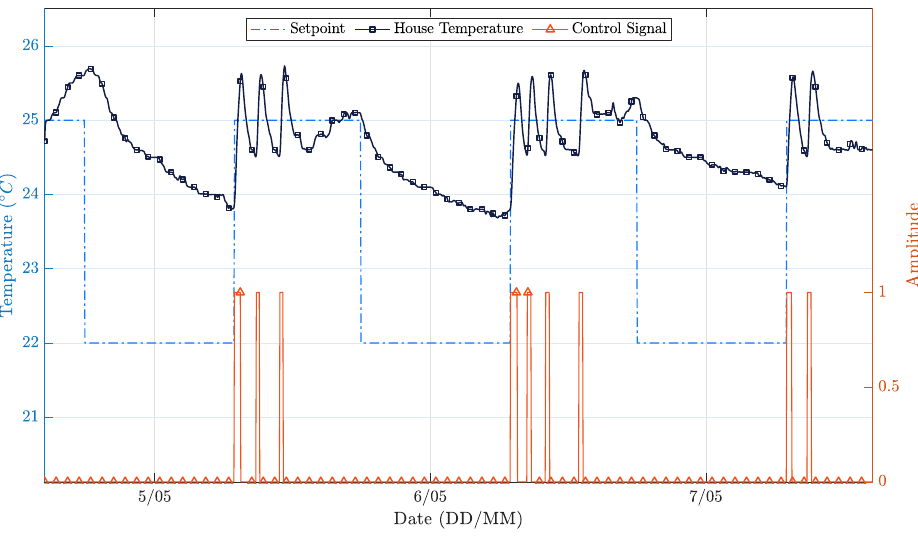
Figure 10. House temperature variation during test time on-off [5].